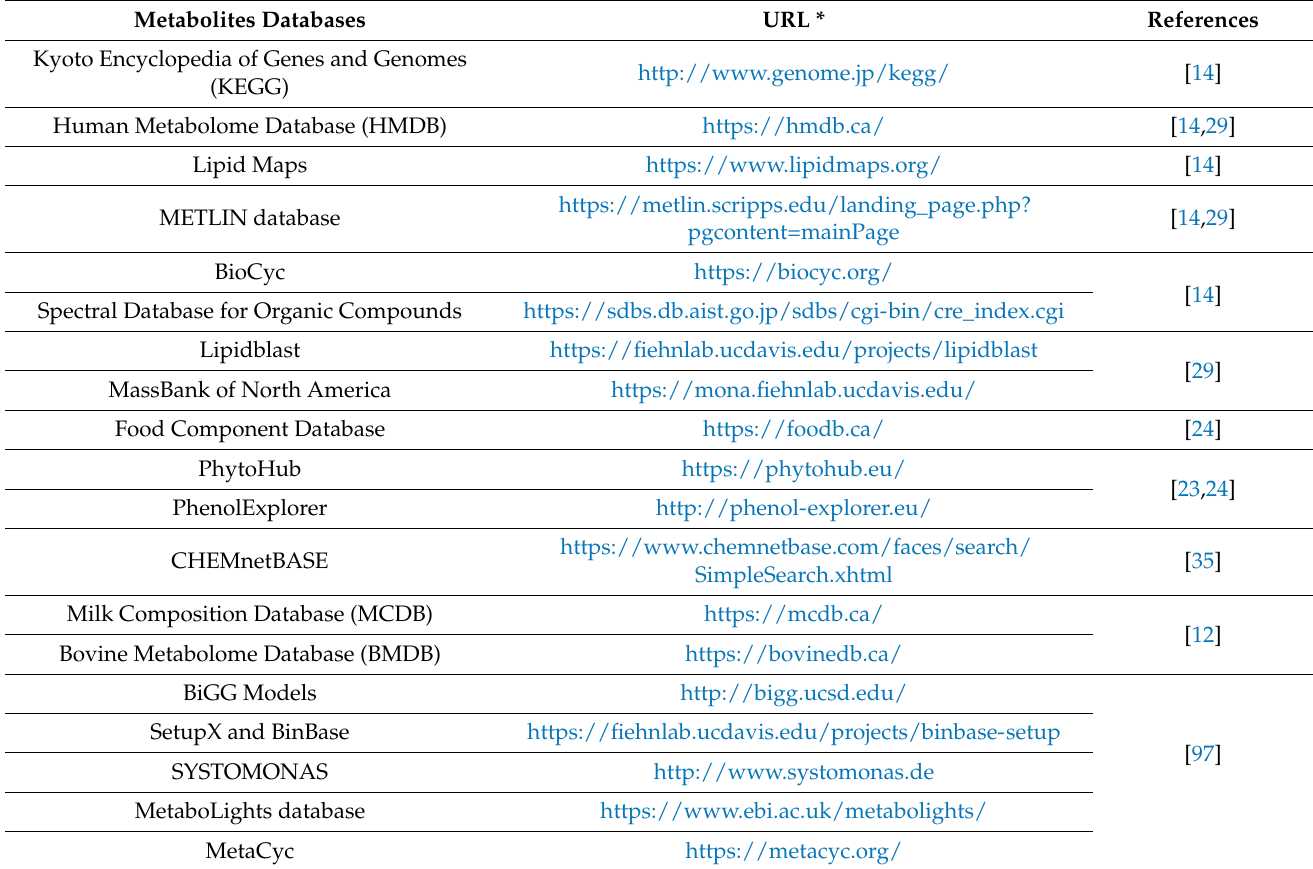
Table 1. Examples of some online omics